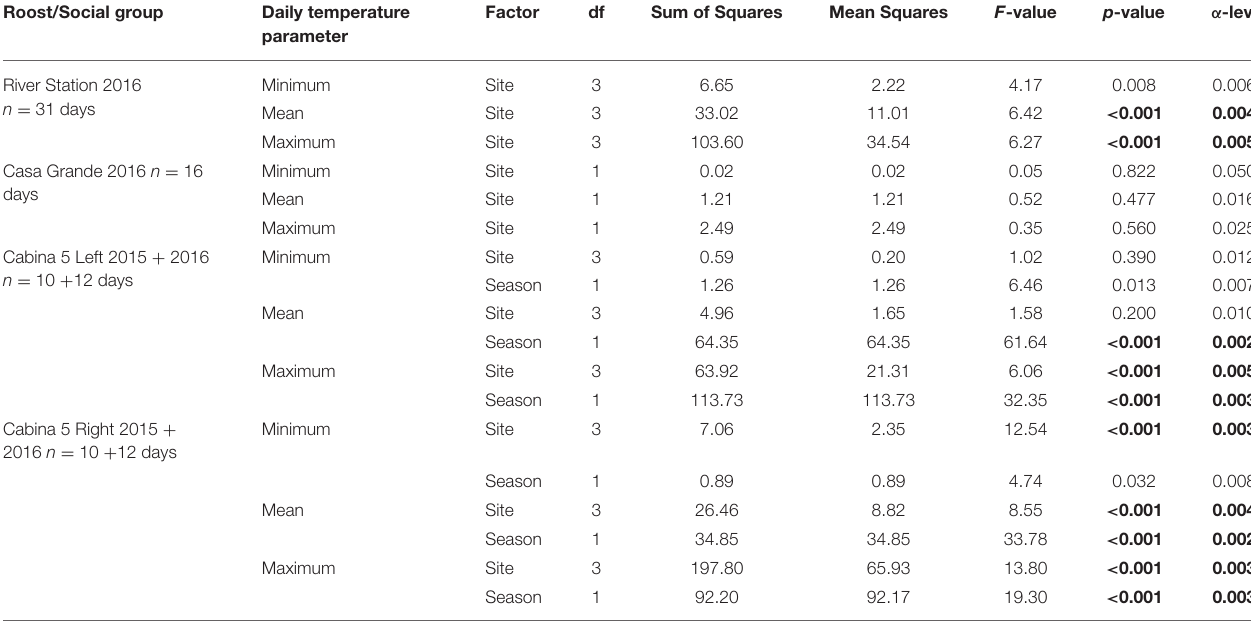
TABLE 3 | Results of one-way ANOVAs (River Station and Casa Grande) and two-way ANOVAs (Cabina 5R/L) comparing differences in daily temperature parameters (site) and, if applicable, season (dry/mating season and wet/non-mating season) between roost sites. Roost/Social group Daily temperature Factor df Sum of Squares Mean Squares F -value p -value α -level parameter River Station 2016 n = 31 days